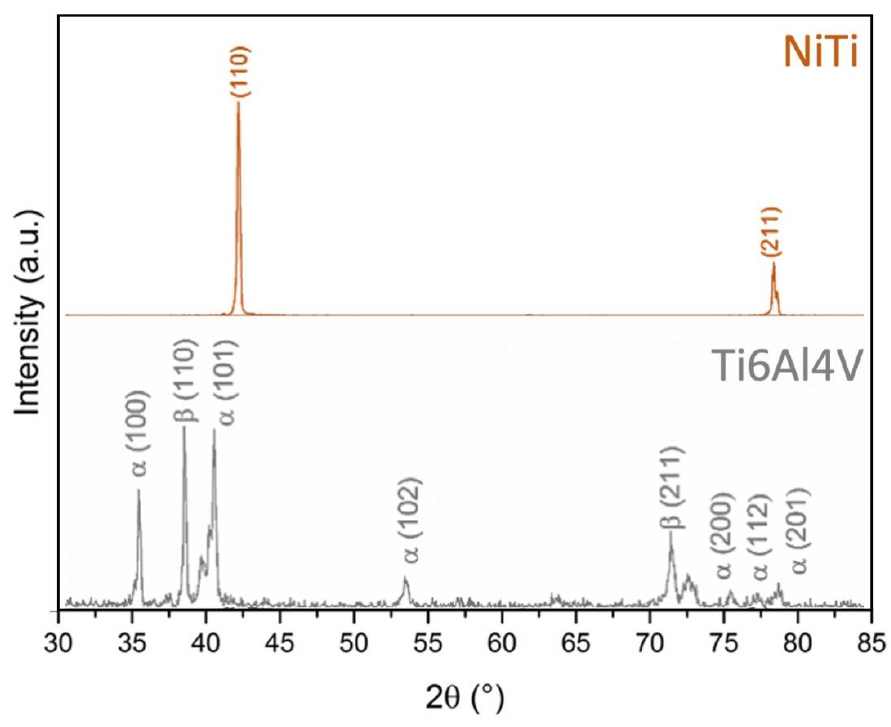
Figure 3. XRD spectrum results of LB-DED NiTi alloy ( top row) and Ti-6Al-4V alloy ( bottom row) [4].